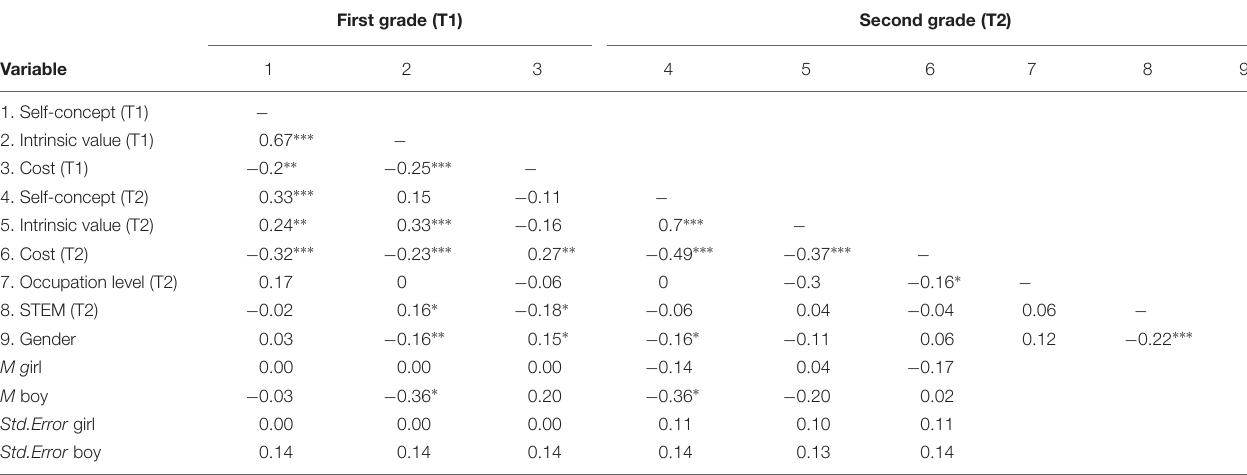
TABLE 2 | Estimated correlation matrix for the latent variables.